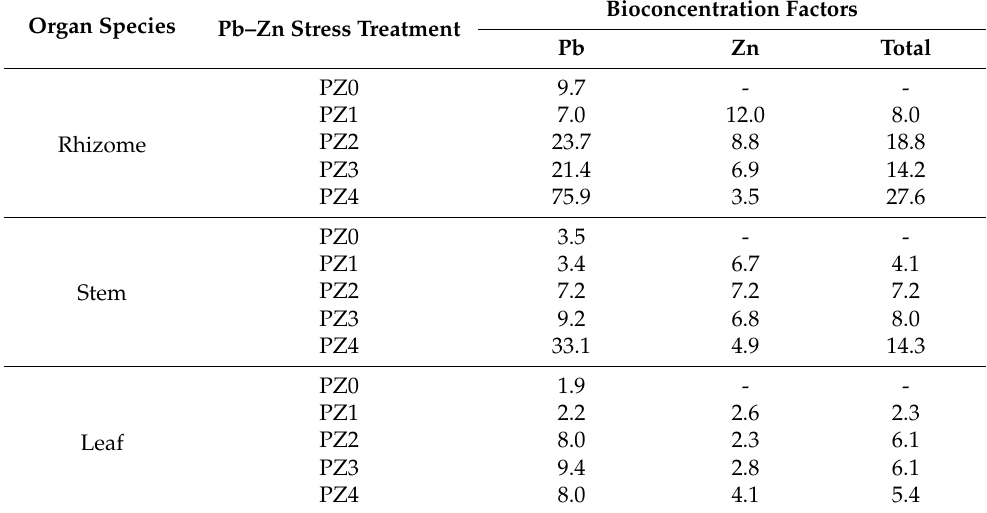
Table 2. Cont. Organ